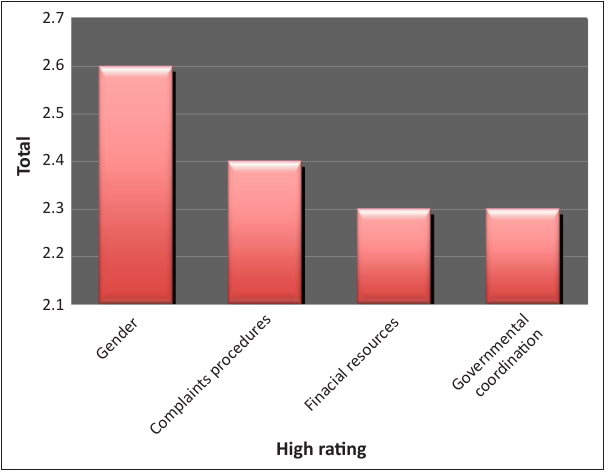
FIGURE 7: Highest scores for local risk governance.